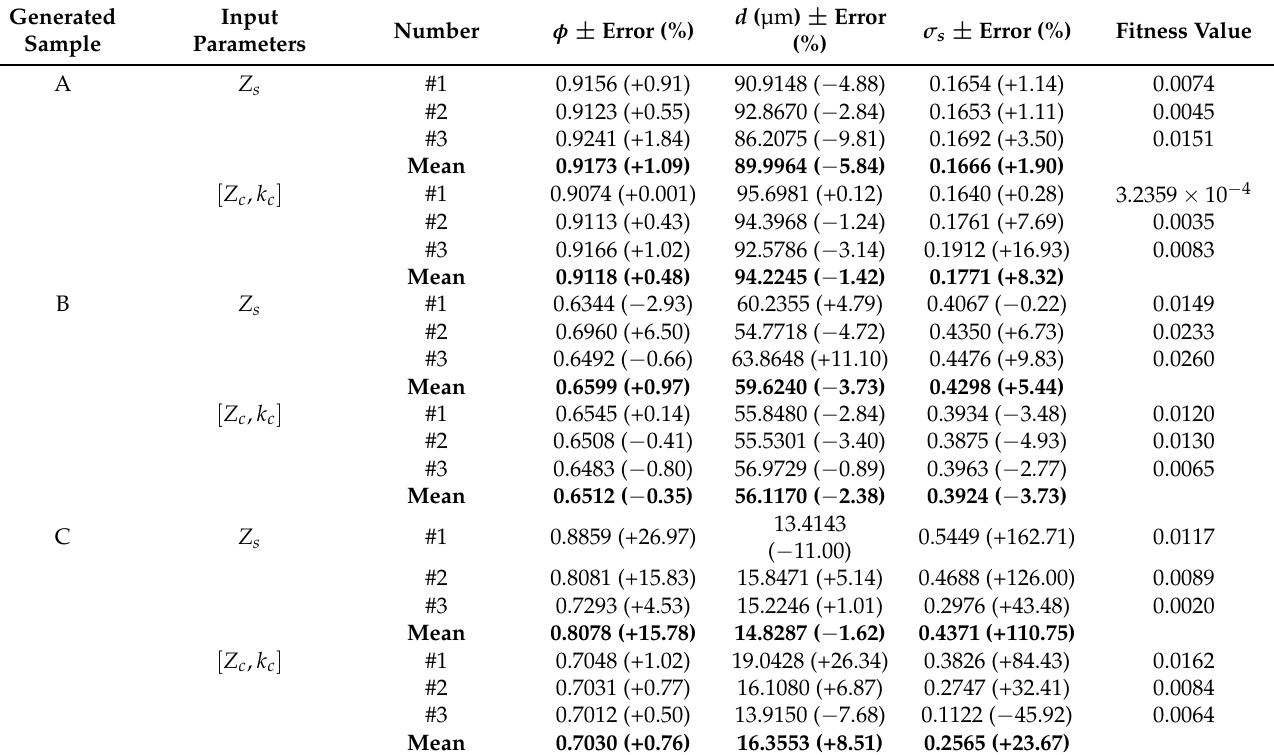
Table 6. Transport parameters identified using GA from the surface impedance Z s and two acoustic properties [ Z c , k c ] with relative errors between the theoretical and optimal values. The mean relative errors for each input parameter are given in